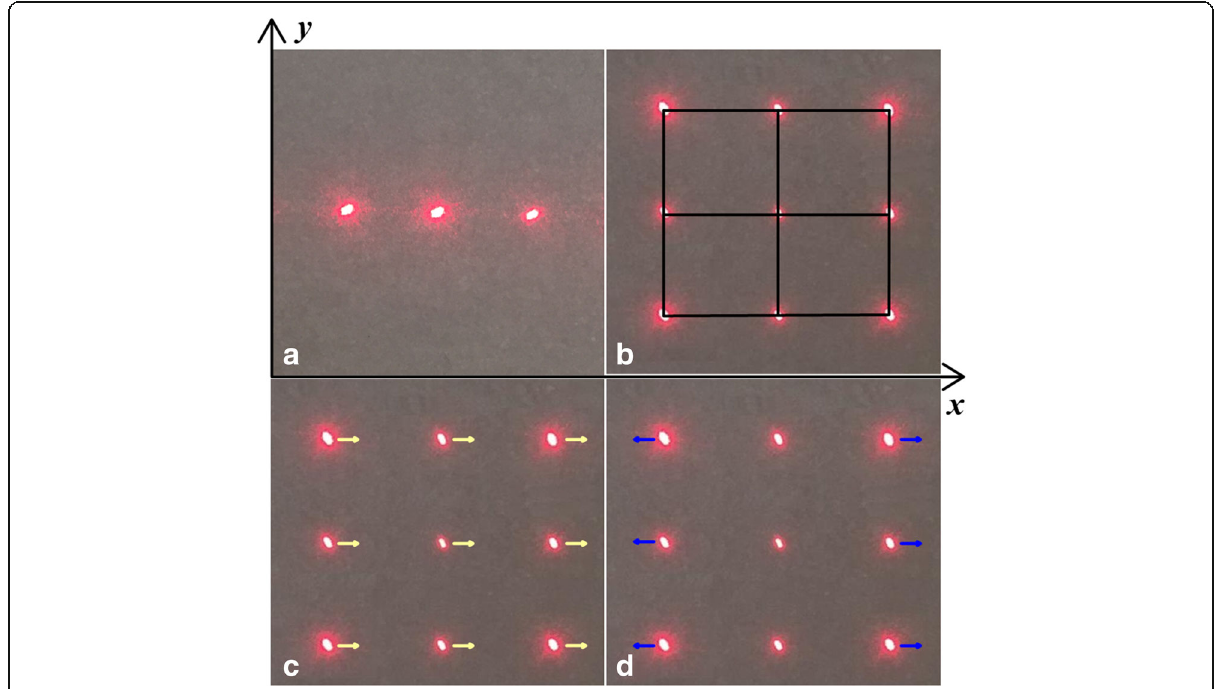
Fig. 3 The MODF motion parameter depends on the moving of diffraction spots. a One-dimensional diffraction spots were generated by the single-direction grating. b Two-dimensional spot array was generated by the double cross optical grating. c Moving of spot array was controlled by the moving of laser source. d Gap moving between the spot array was controlled as the incident angle of laser